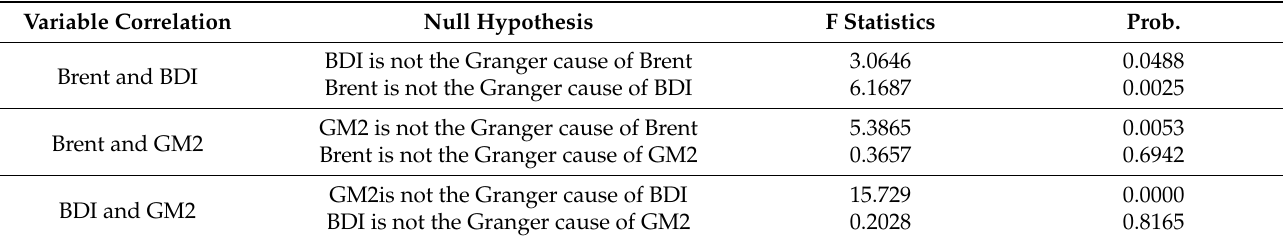
Table A1. Granger causality test.